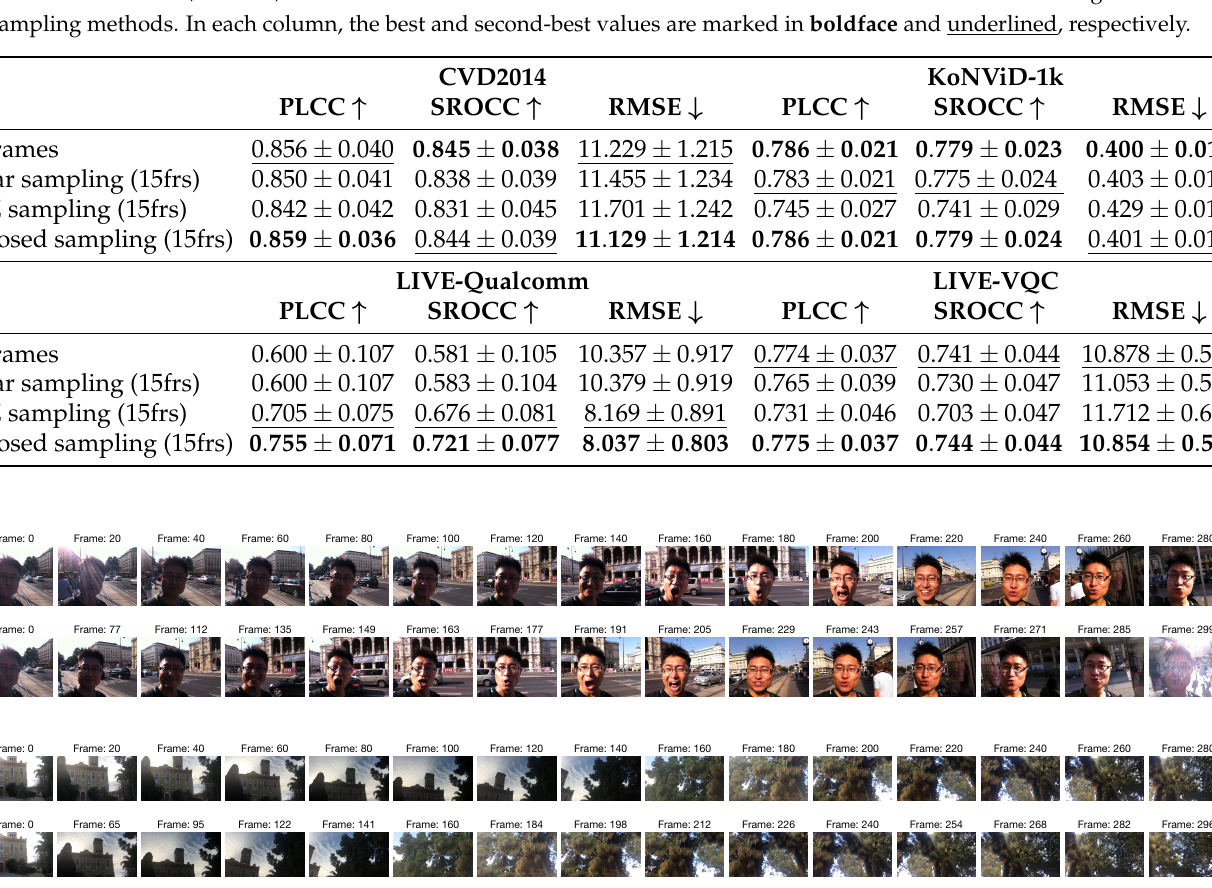
Figure 12. (Best viewed in colors and magnified.) Linear vs. our frame sampling. Two example videos are shown in which the 15 frames sampled linearly or with the proposed sampling algorithm are